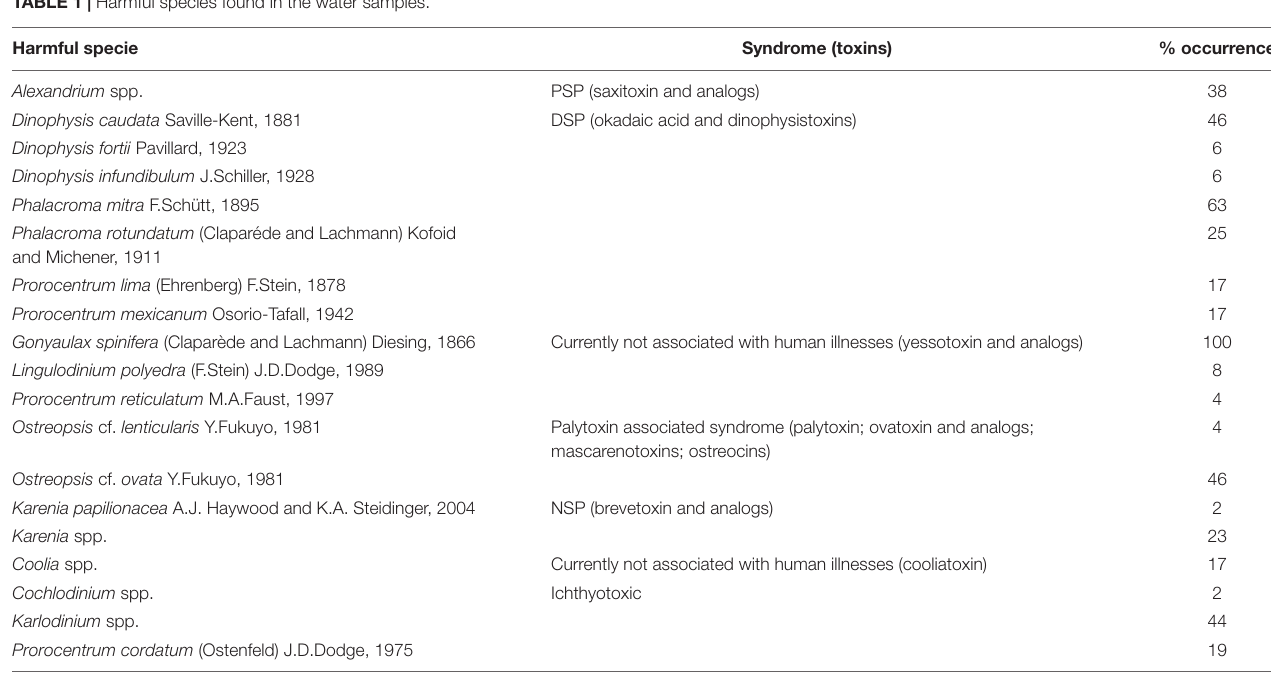
FIGURE 5 | Environmental association of (A) Dinophysis caudata , (B) Karlodinium spp., and (C) Ostreopsis spp. to temperature ( ◦ C), salinity and pH (upper, central, and lower panel, respectively). Central (blue) line represents the fitted GALoM model where the presence/absence probability is modulated for different environmental variable values, while keeping the rest variables at constant (average) values. Gray (shaded) areas represents the confidence intervals (i.e., uncertainity) associated to the fitted models. TABLE 1 | Harmful species found in the water